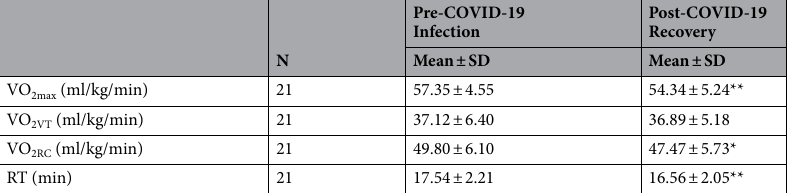
Table 4. Maximal oxygen uptake (VO 2max ), oxygen uptake at ventilatory threshold (VO 2VT) , and respiratory compensation point (VO